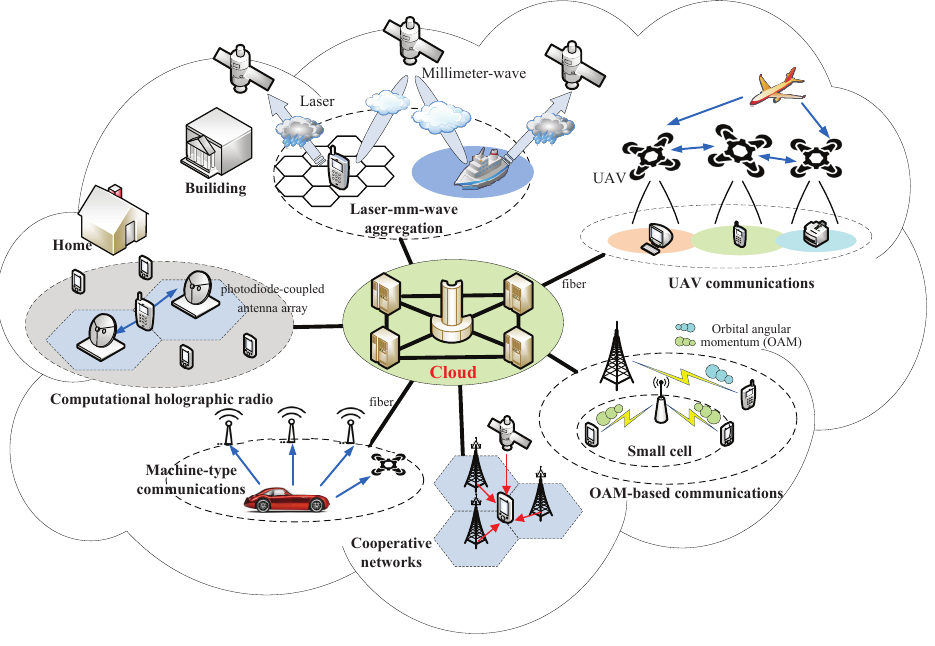
Figure 1. Cloud-based radio access network architecture for 6G mobile communications systems.